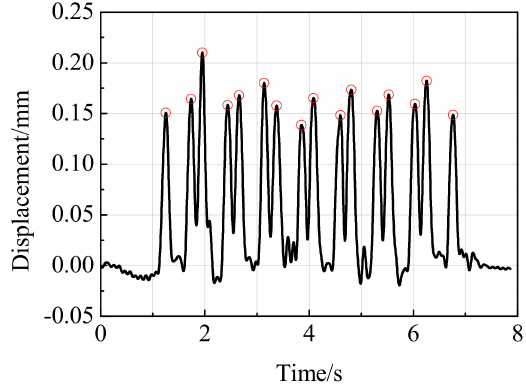
Figure 9. Low-pass filtered displacement signals (the red circle indicates the passing moments of the train